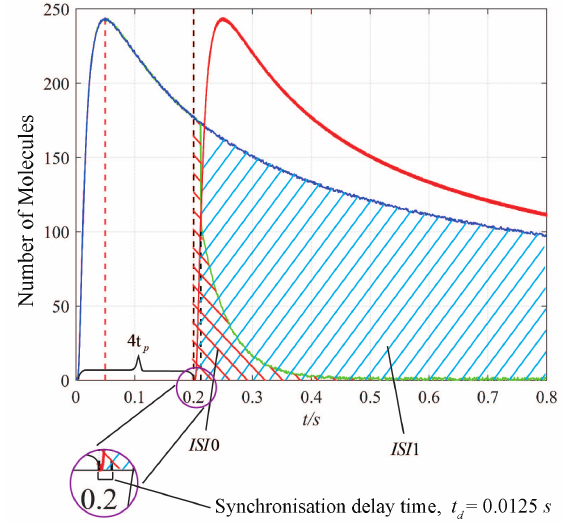
Figure 4. ISI illustrations in two different scenarios, in which the two connected symbols is “11” and “10”. The blue line and the red line denote the received signals when the previous symbol “1” and the current symbol “1”, while the green line denotes the received signal when the previous symbol “1” and the current symbol “0”. The ISI-0 (green shadowed area) denotes the ISI when transmitted symbols are “10”, and ISI-1 (blue shadowed area) denotes the ISI when transmitted symbols are “11”. The time interval of symbols T b = 4 t p = 0.2 s.The red dashed line denotes the time to reach the peak concentration t p = 0.05 s, the black dashed line indicates the synchronization delay time at the current symbol, the delay is t d = 0.0125 s.